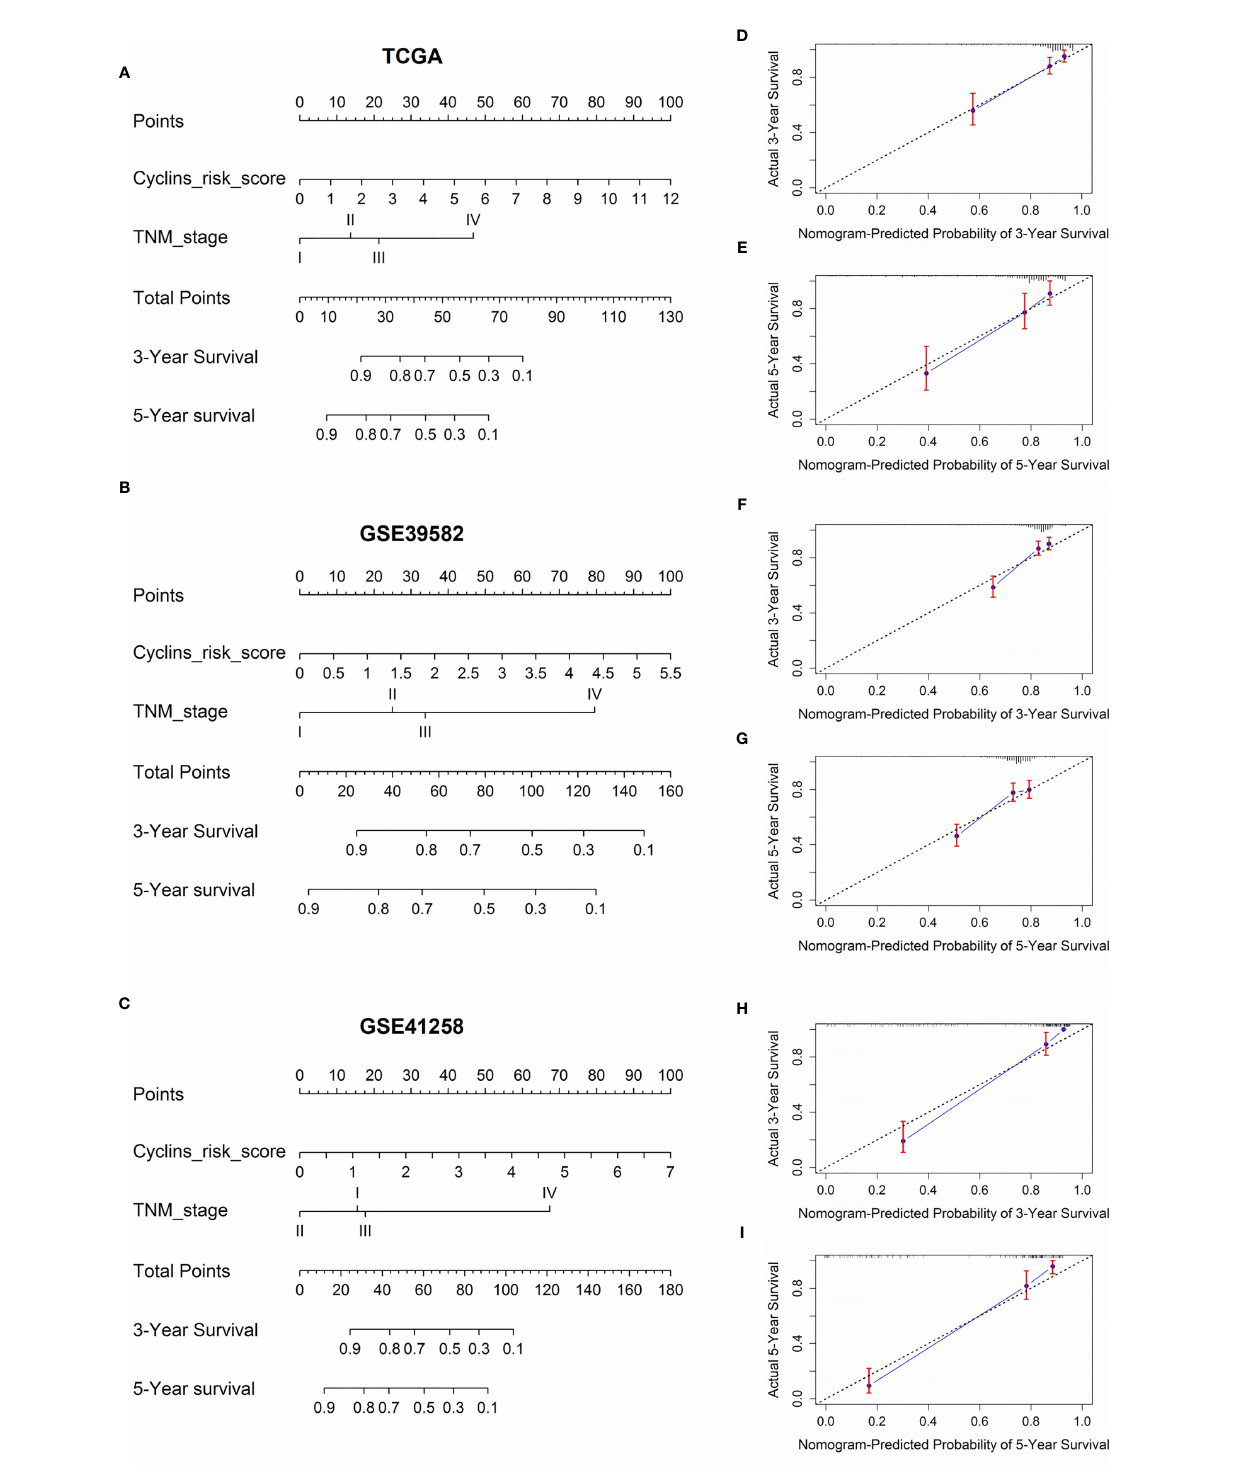
FIGURE 8 | Nomograms to predict the probability of three- and fi ve-year survival in patients with colon cancer. (A – C) Prognostic nomograms according to the risk score of the prediction models integrating 24 cyclin genes and TNM stage. The value on the lines of each variable corresponds to a point on the “ Points ” line. The sum of these points on the “ Total Points ” line corresponds to the probability of three- and fi ve-year survival. (D – I) Calibration curves indicated the predictive accuracy of the nomograms. The black dotted line is a reference line. Red bars and blue lines represent error bars and calibration lines,